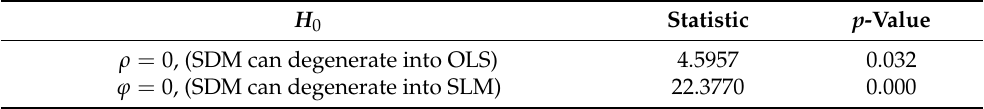
Table 5. LR Test for spatial econometric model.